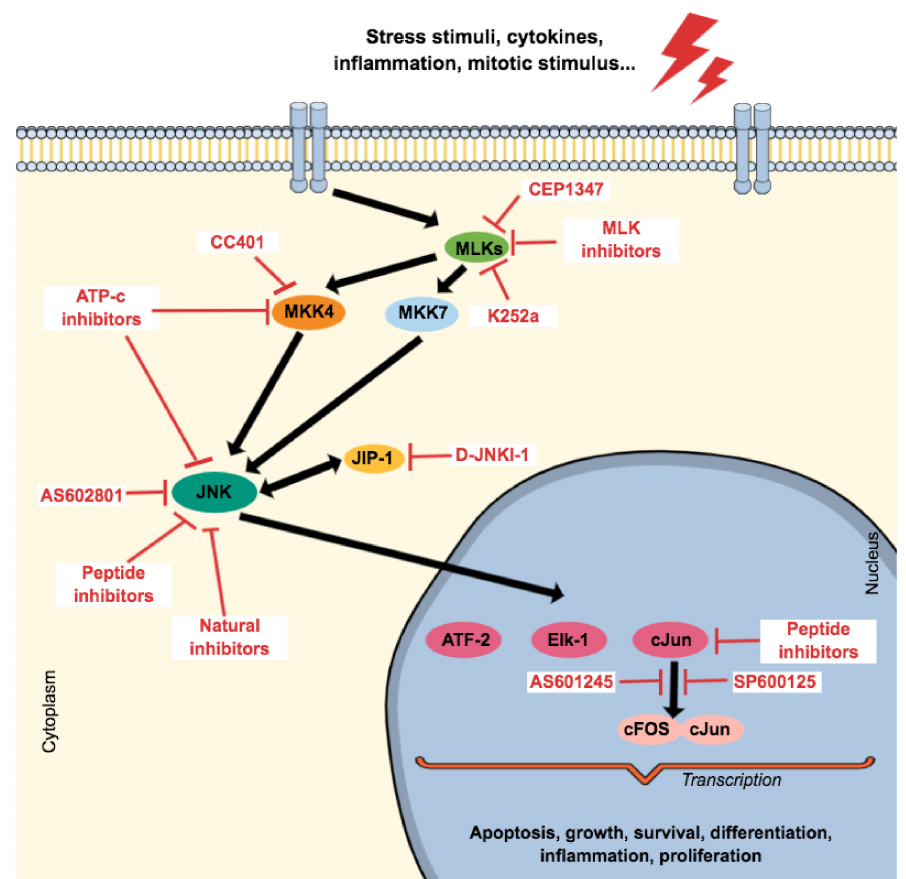
Figure 6. Schematic representation of the mechanism of action of JNK